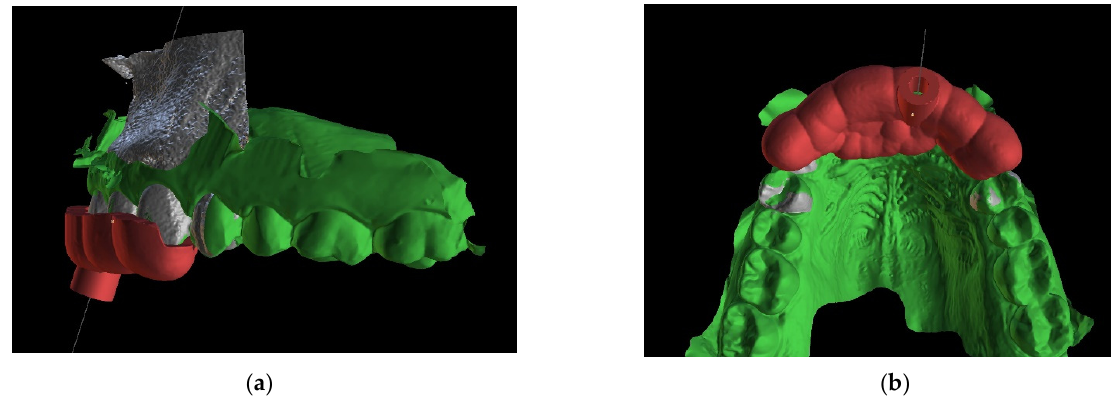
Figure 12. The range of the guide is drawn on the combined CBCT and STL image. This figure shows the extent of the template ( a ) labially and ( b ) palatally.